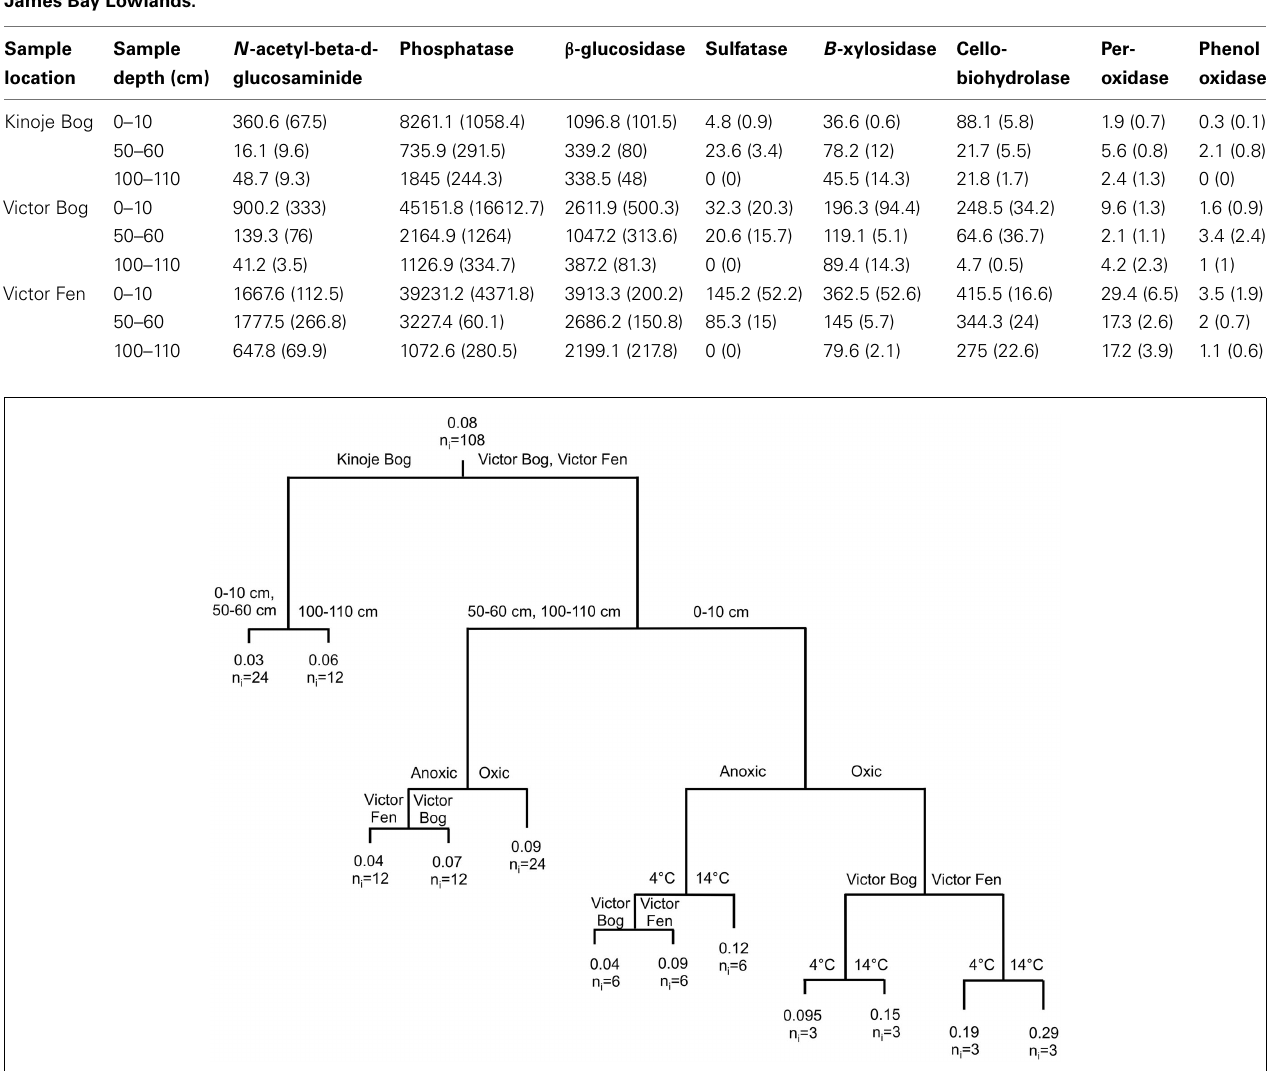
Table 3 |Activity of enzymes (mean ± 1SE nmolh − 1 g − 1 ) within peat soil collected at three depths ( n = 3) from peat cores collected in the James Bay Lowlands.